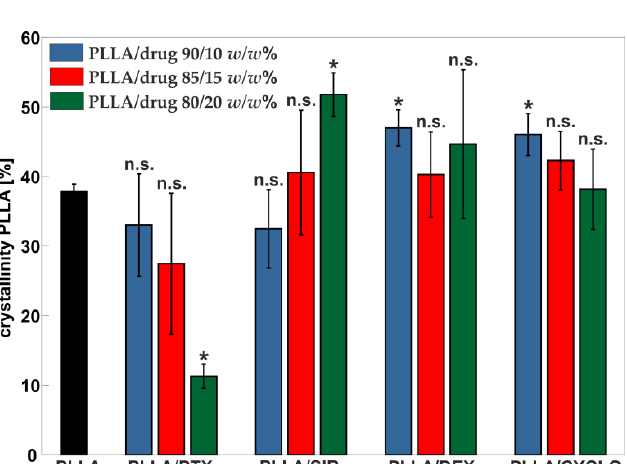
Figure 7. Crystallinity of PLLA in PLLA/drug spray coated films with different ratios (90/10, 85/15, 80/20 w / w %), determined from DSC measurements. Asterisks (*) mark significant differences of crystallinity data with p < 0.05 obtained by two-tailed t -test, each in comparison to PLLA reference. n.s. stands for not Table 3. DSC results (glass transition ( T g ), melting temperature ( T m ) and degree of crystallinity ( χ )) of PLLA/drug spray coated films in different ratios (90/10, 85/15, 80/20 w / w %) (n = 5 for each group).